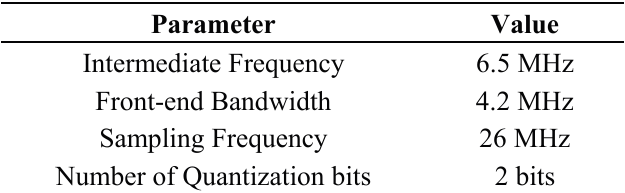
Table 1. NSL stereo v2 front-End configuration for BeiDou B1I signal